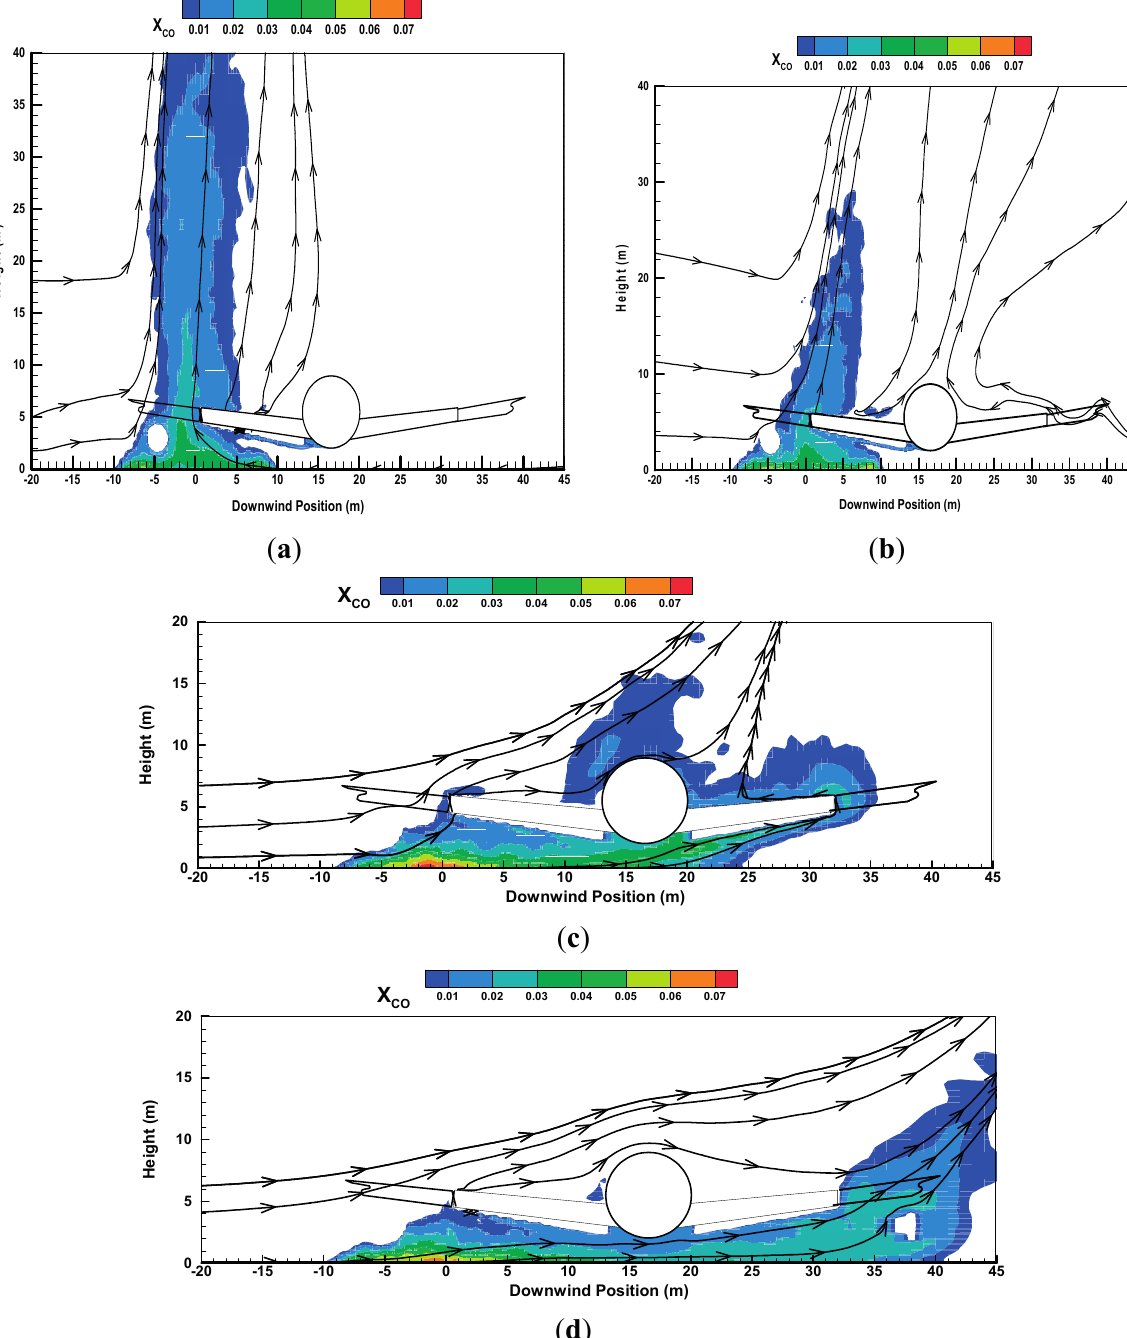
Figure 14. Contours of the time-averaged CO molar fraction for fires containing an aircraft of the composite type. ( a ) Quiescent condition; ( b ) low wind speed of 2 m/s; ( c ) medium wind speed of 5 m/s; ( d ) high wind speed of 10